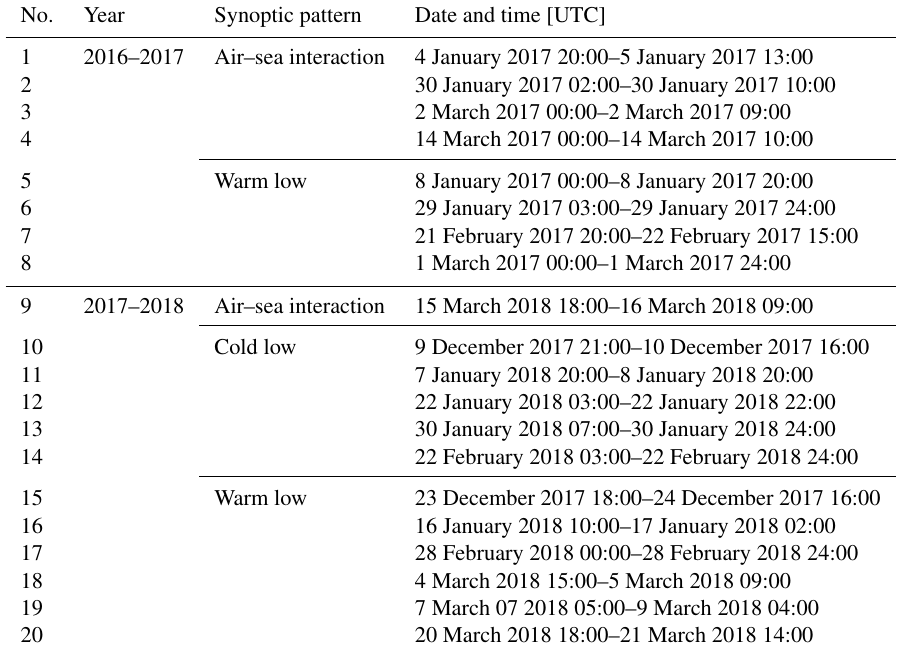
Table 1. Summary of events used in this study. The time is in UTC. No. Year Synoptic